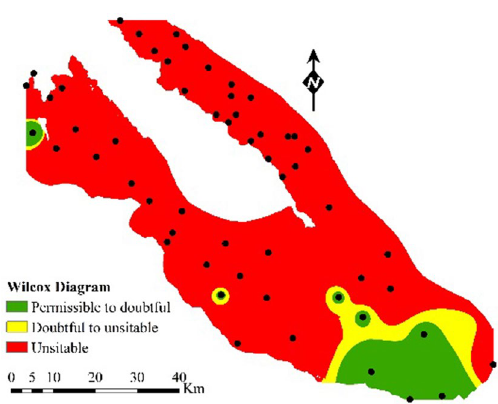
Fig. 13 Categorization of groundwater based on Wilcox diagram for 55 water